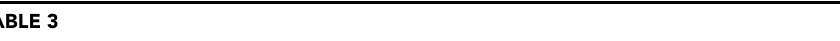
Authority Type Applied to the Indigenous Education Officers Within the School and Indigenous Contexts Authority